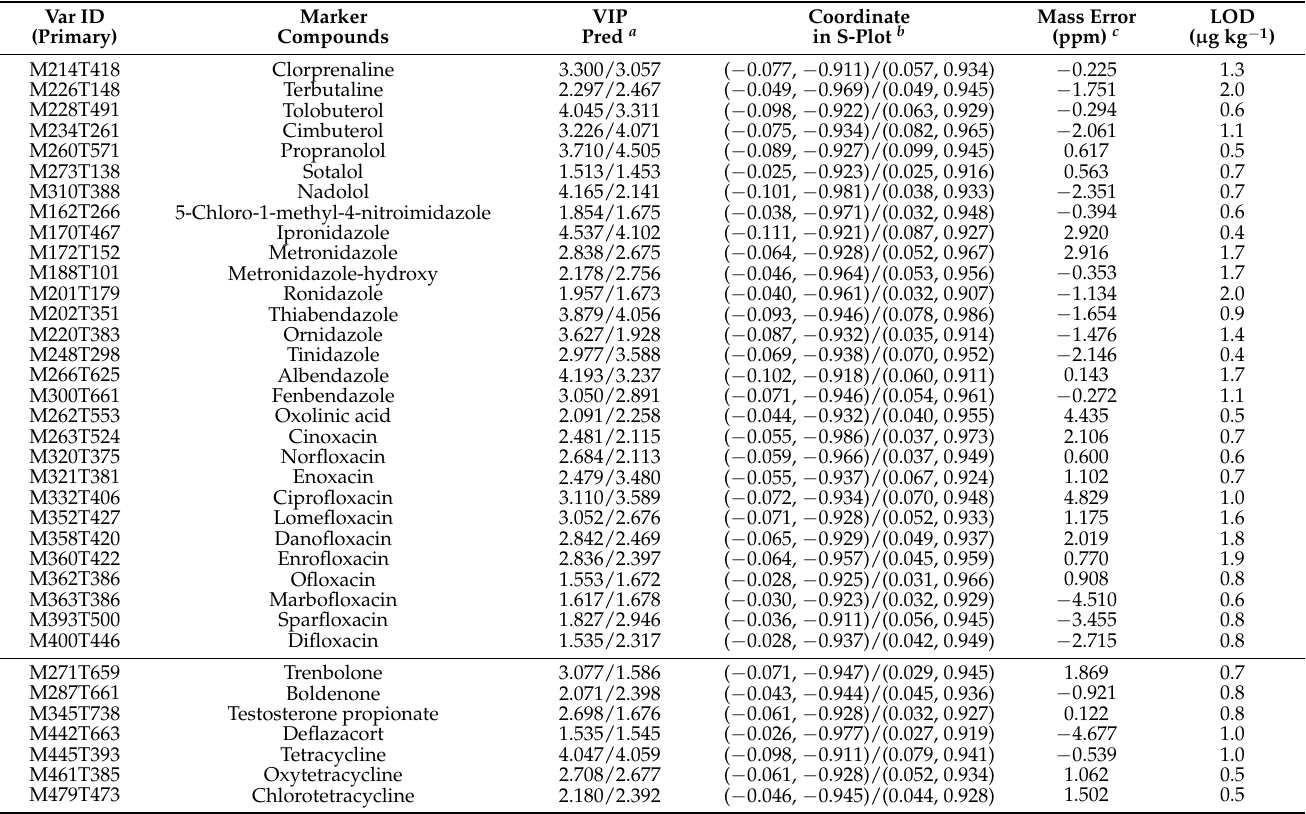
Table 2. Marker compounds screened in lettuce sample groups.